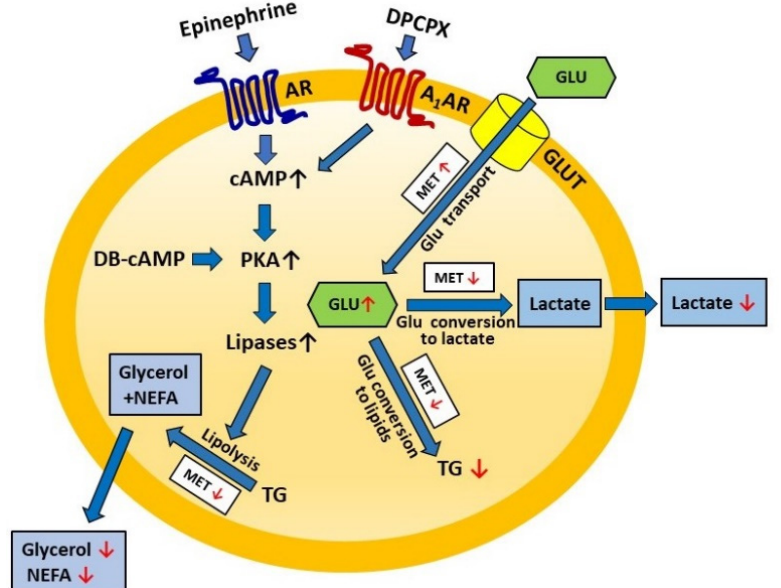
Figure 9. Schematic representation of metformin action on adipocyte lipolysis and lactate release. DPCPX—adenosine A 1 receptor antagonist; AR—adrenergic receptor; A 1 AR—adenosine A 1 receptor; DB-cAMP—dibytyryl-cAMP (cAMP analog); PKA—protein kinase A; TG—triglycerides; NEFA—non-esterified fatty acid; GLU—glucose; GLUT—glucose transporter; MET—metformin; red arrow—metformin effect.